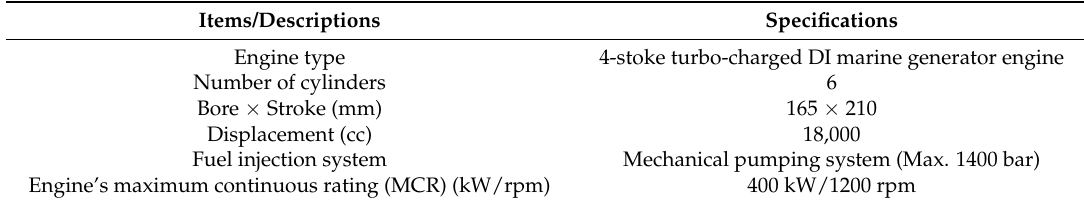
Table 2. Specification of the test engine.